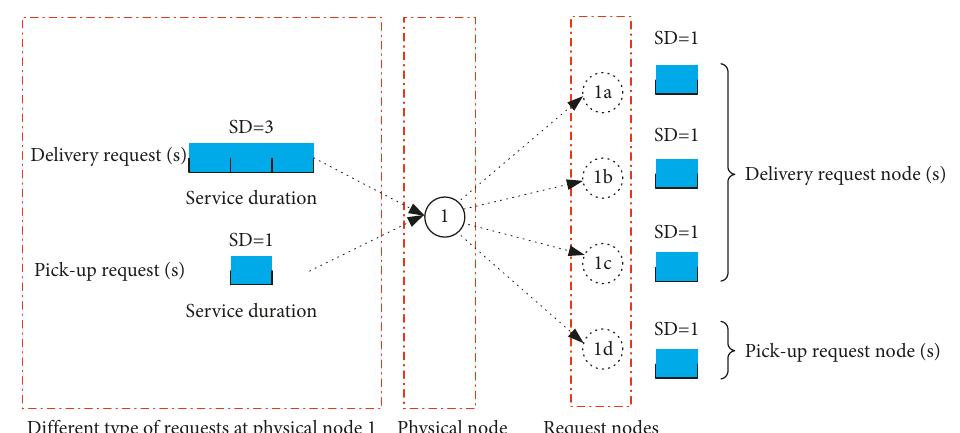
Figure 4: The process of generating request nodes.